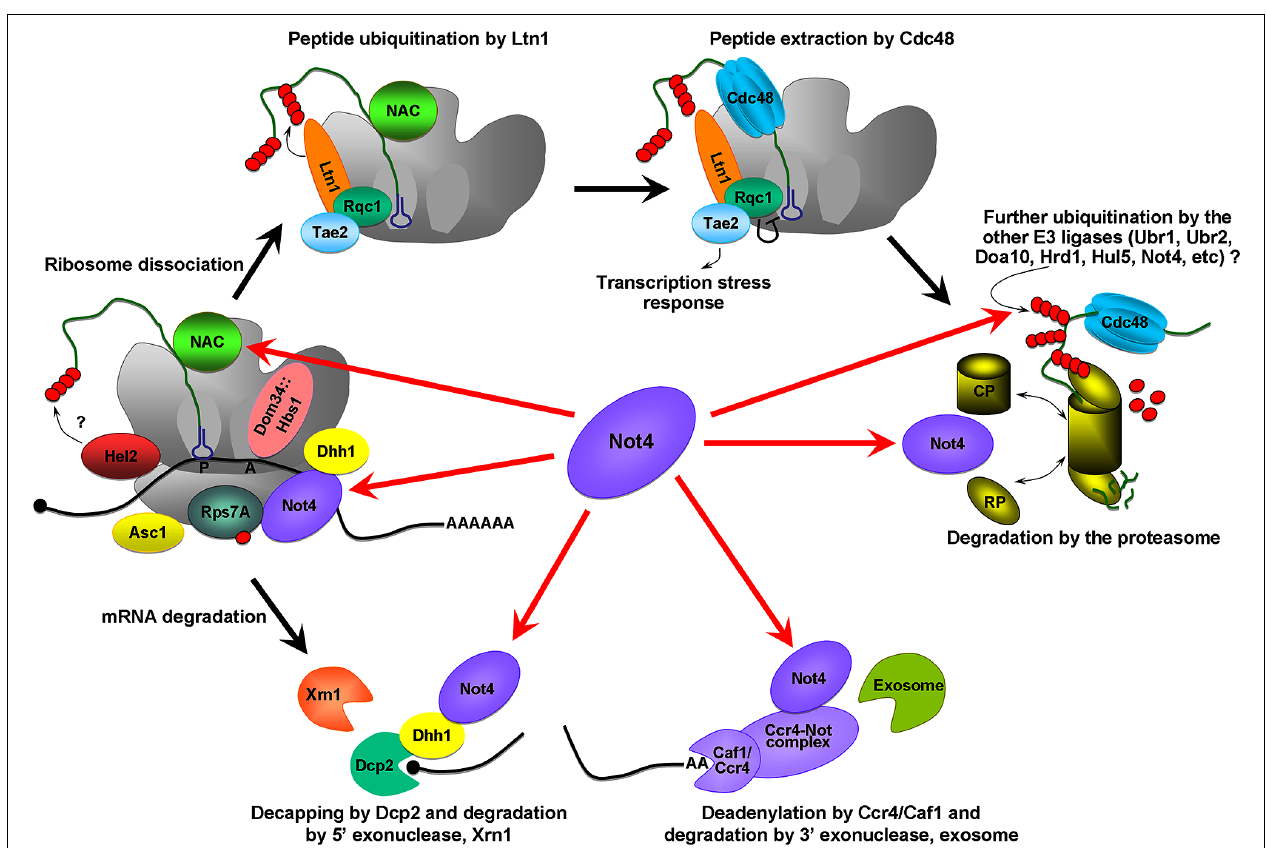
of the RQC by a negative feedback loop, and Tae2 signals translational stress to the corresponding transcription factors (Brandman etal., 2012). Extracted peptides are probably subjected to further ubiquitination by other E3 ligases and finally degraded by the proteasome. The red arrows indicate the possible pathways by which Not4 may act. Not4 may ubiquitinate translationally arrested peptides. It may also be involved in the clearance of arrested protein products by the proteasome. Not4 may preserve translation acting through several targets; the deadenylase module of the Ccr4-Not complex, Dhh1, the ribosome-associated chaperone, NAC, and through the ubiquitination of Rps7A. Finally, Not4 may interact with mRNA and “sense” ribosome pausing and/or recruit the factors necessary for correct